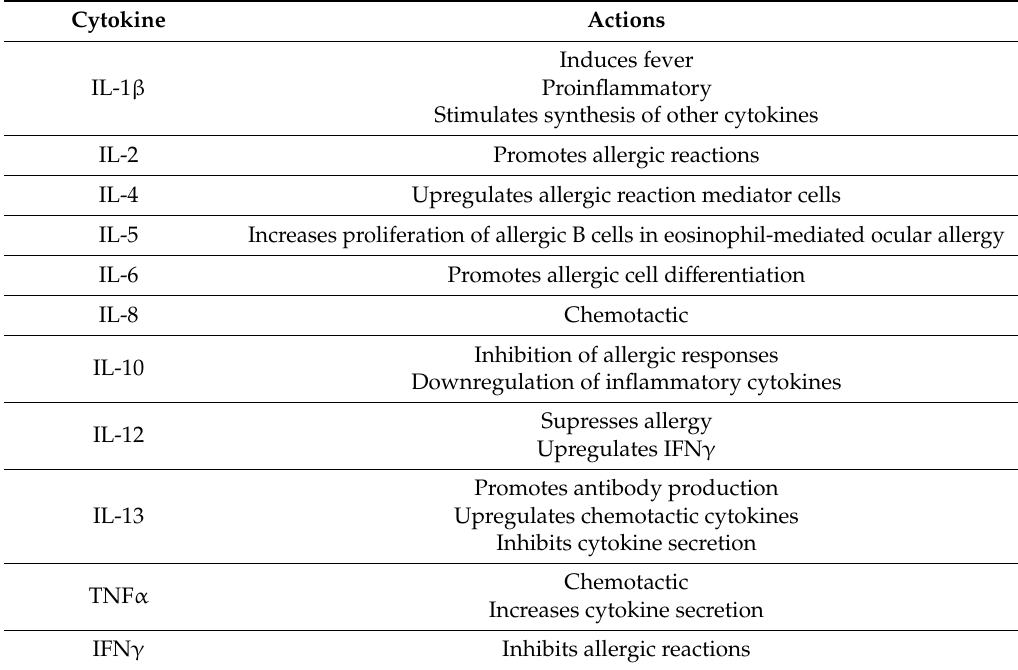
Table 2. Summary of the actions of cytokines detected on the ocular surface in ocular allergy and contact lens wear. Adapted from Broide et al. to specify allergy and cytokine interactions [21,30–33]. IL, interleukin; TNF, tumour necrosis factor; IFN,